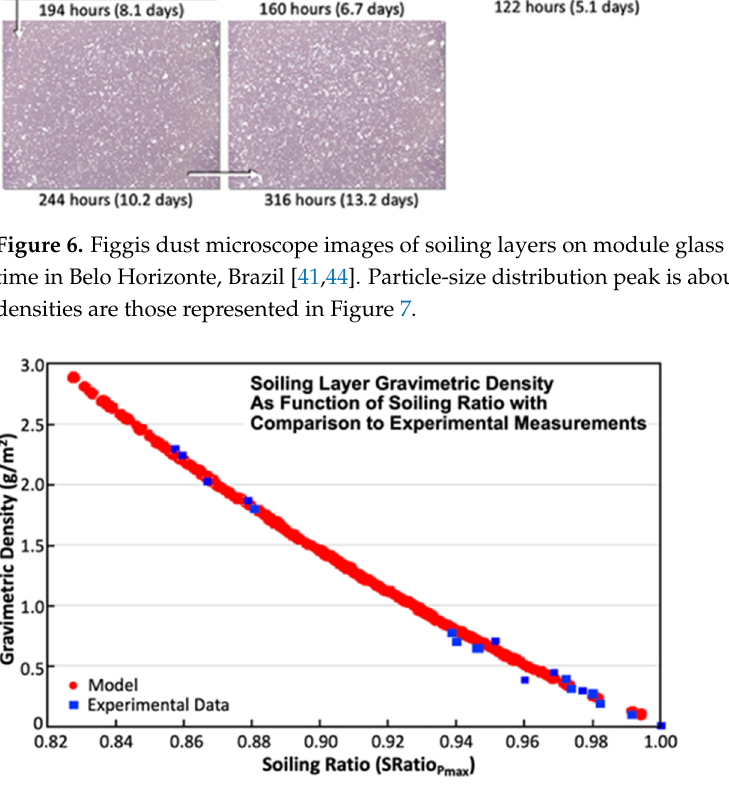
Figure 7. Comparison of gravimetric density upon SRatio for Belo Horizonte, Brazil, based on mod- eling by Coello and Boyle [42] and Costa [43]. Experimental data from present study (blue squares) show good agreement with this analytical evaluation.